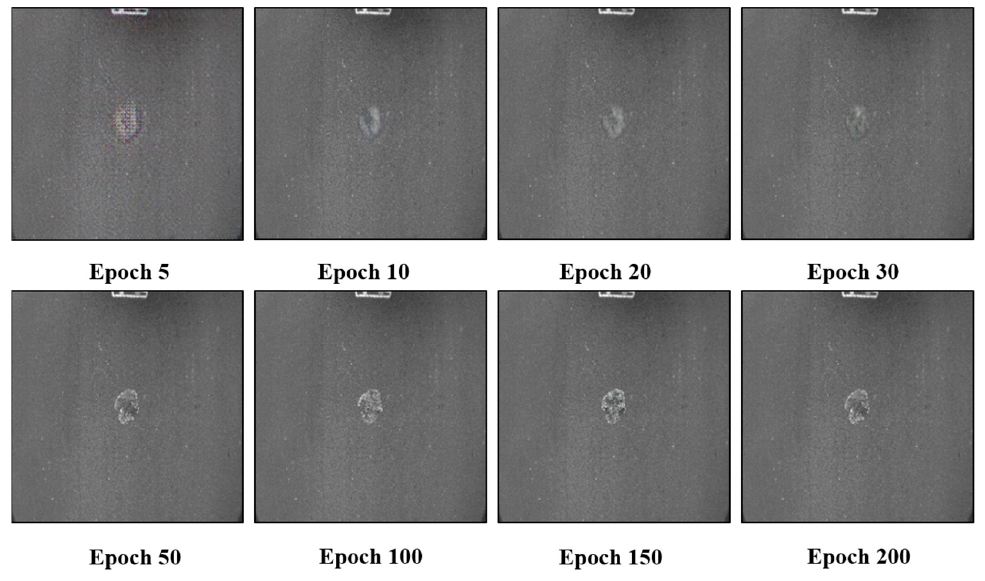
Figure 12. Generated results by different epochs models.